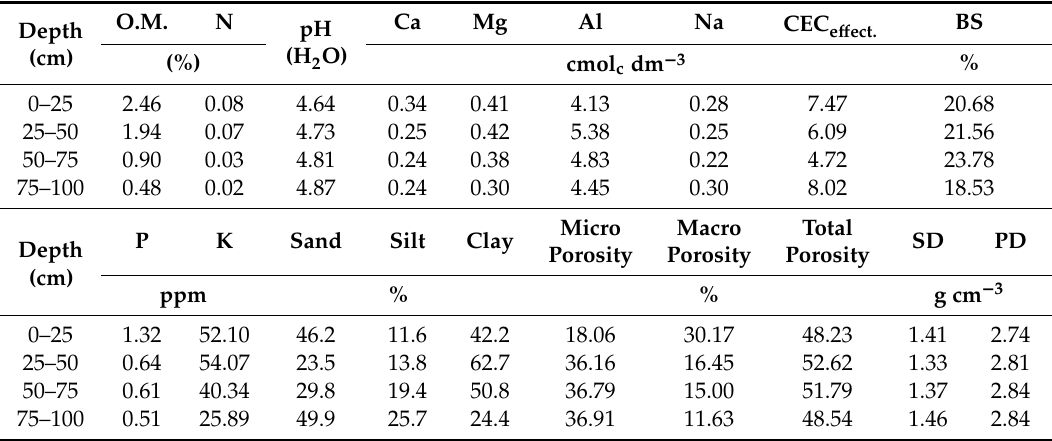
Table 1. Soil chemical and physical properties of the Eucalyptus urophylla × Eucalyptus globulus plantation ( n = 9 repetitions), 10 years after establishment.